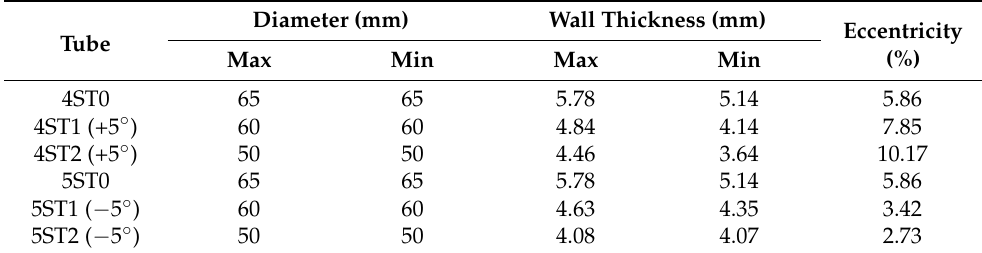
Table 3. Dimensions of Cu tube before and after drawing with a tilted die.